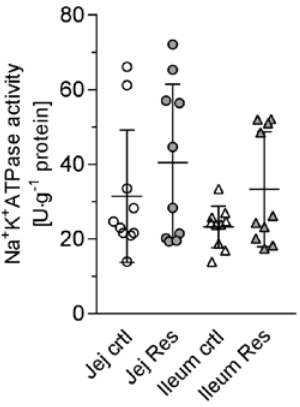
Figure 4. Activity of Na + /K + -ATPase in jejunal and ileal control and resveratrol-treated samples as measured in tissue homogenates. No significant changes after resveratrol incubation were observed (paired t-test, MW ± SD, n = 10).